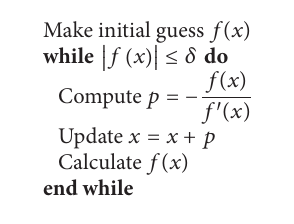
Algorithm 1: Newton-Raphson method.